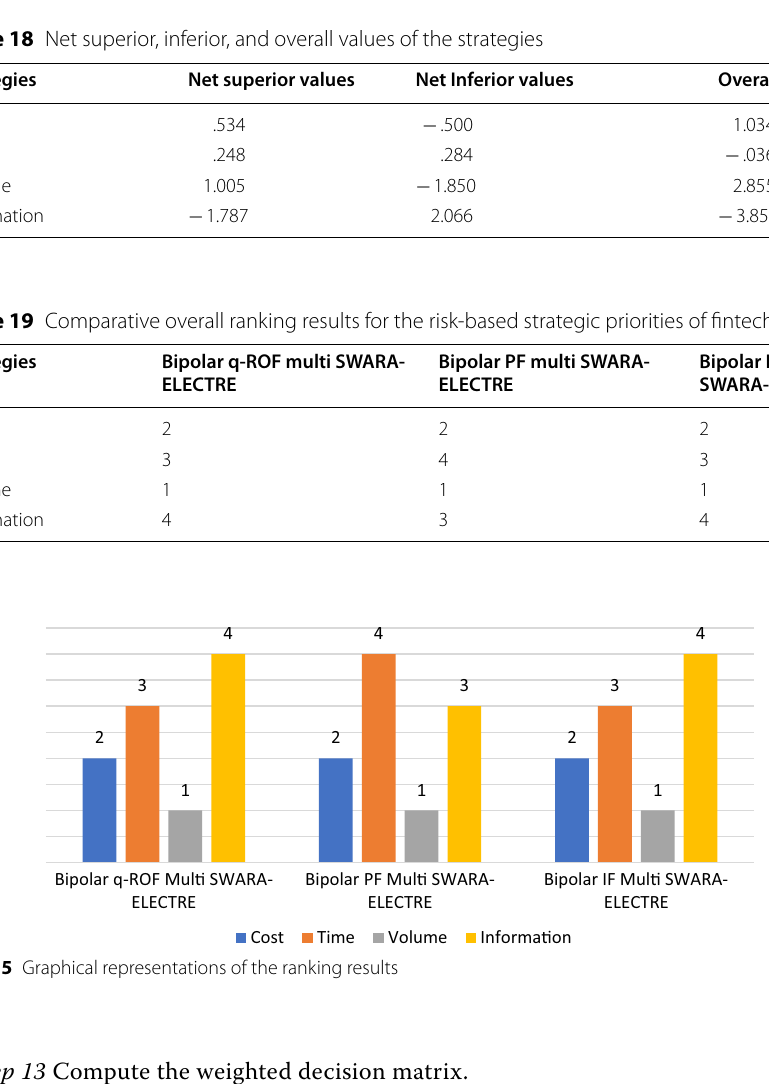
Step 15 Compute aggregate index matrixes.